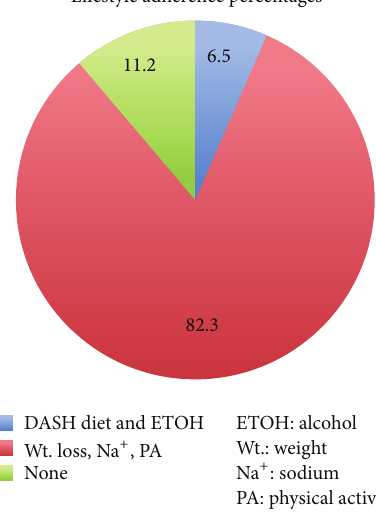
Figure 3: Lifestyle